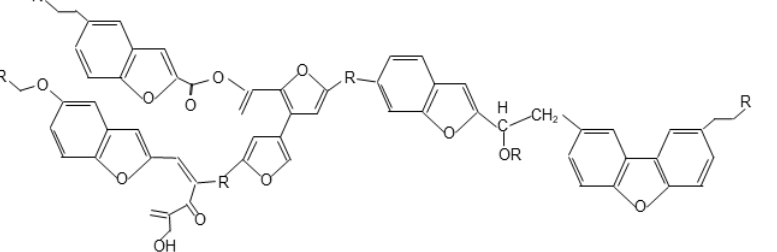
Figure 6. Conceptual model describing the aromatic network in the cellulose residue pyrolyzed at 350 °C for 1 h according to compounds identified with the solid-state 2D 1 H- 13 C HETCOR NMR technique.